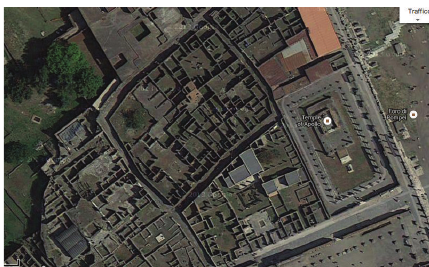
Figure 1: Comprehensive view of the archaeological site of Pompeii (Region VI).